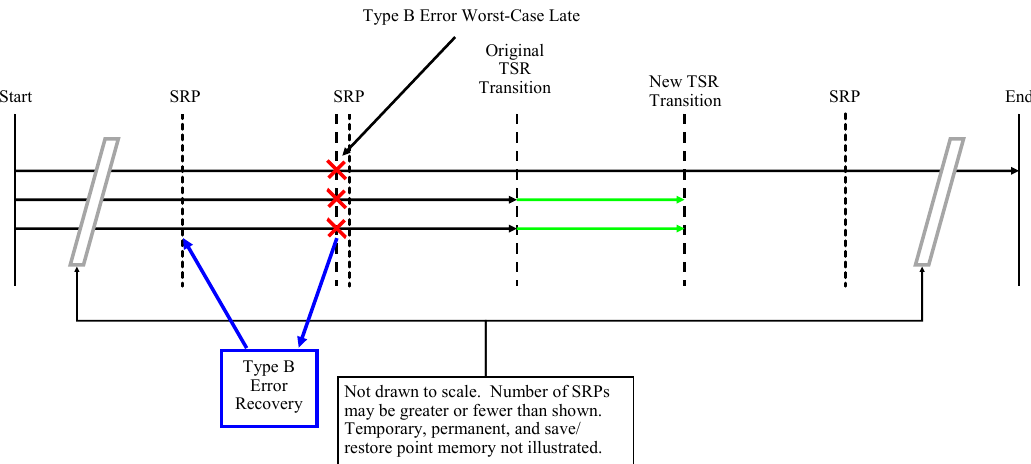
Figure A12. AHR MIPS TMR Type B Worst-Case Late error timing